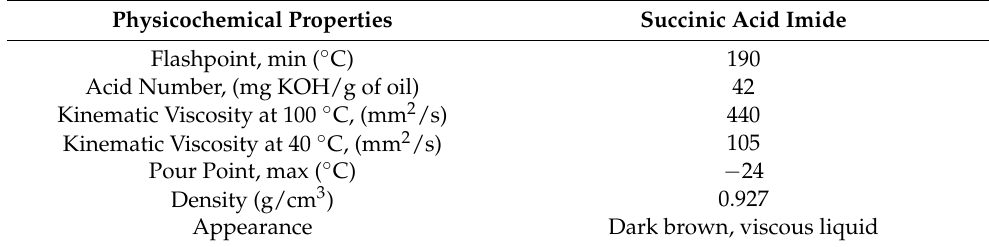
Table 4. Succinimide